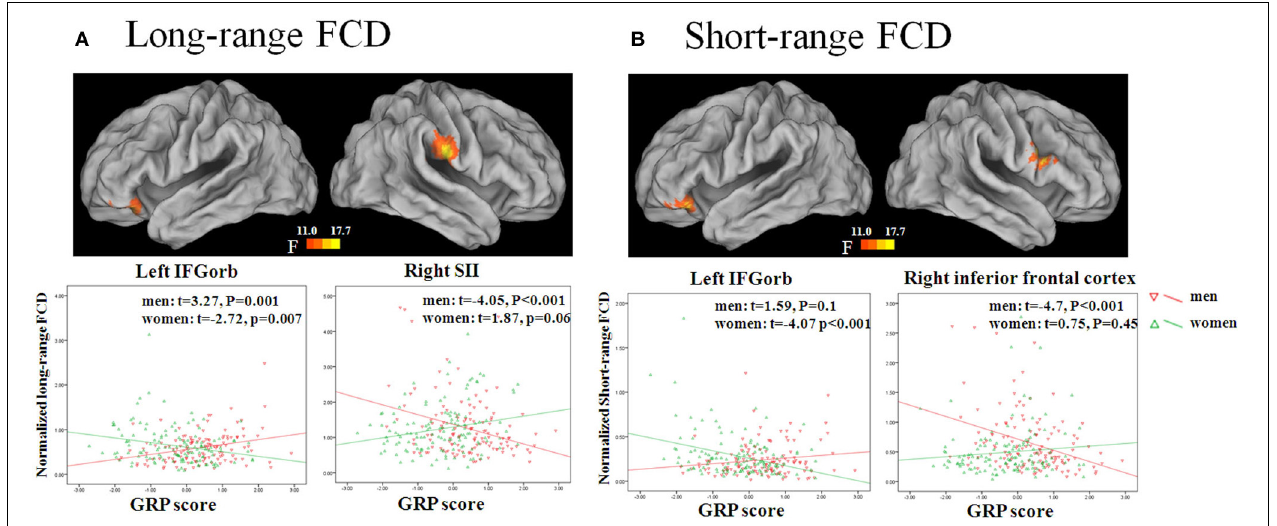
FIGURE 2 | Sex by GRP interaction effect for long-range FCD (A) and short-range FCD (B). The images were created using the CARET 5.62. Scatter plots show GRP-related changes in long- or short-range FCD in the male and female group. The lines are linear fits of the data.